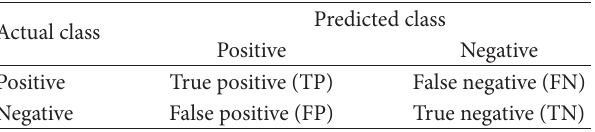
Table 1: The four classification performance indices included in the confusion